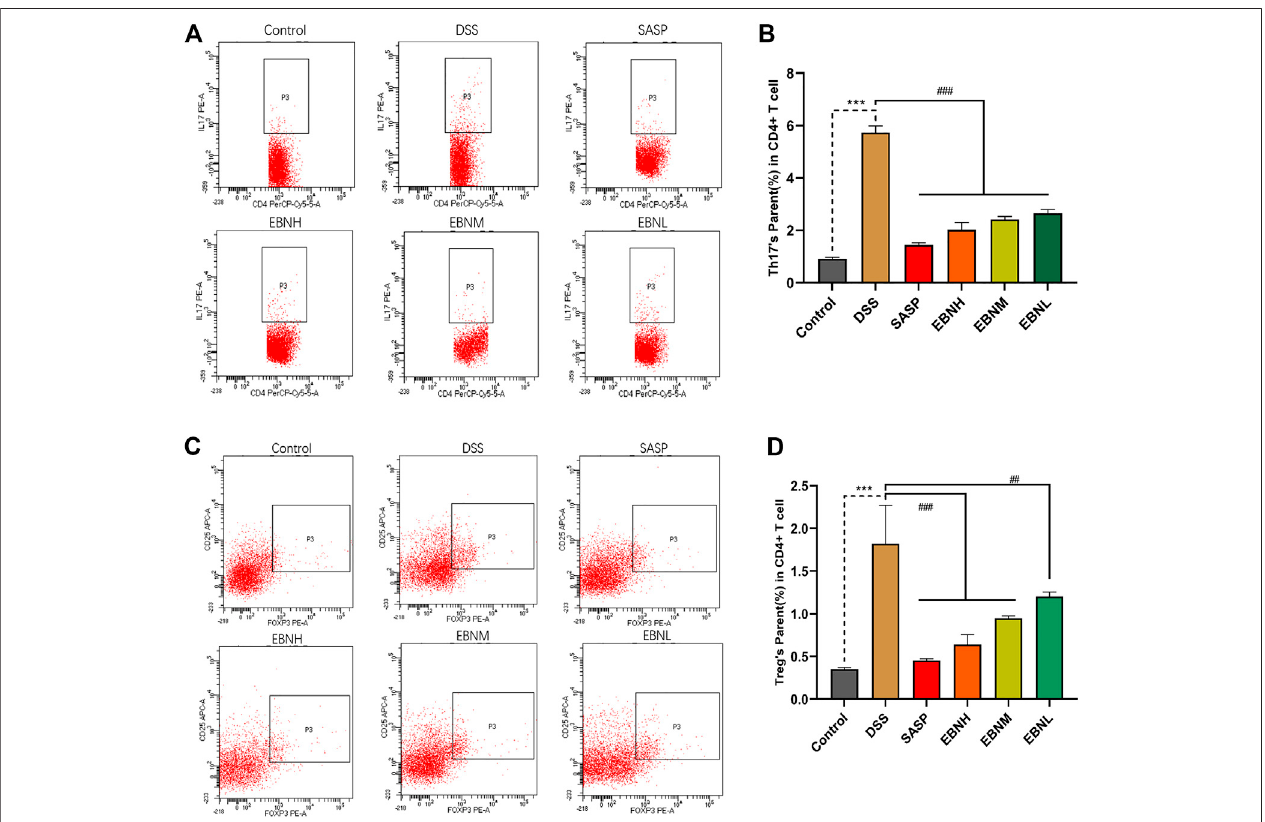
FIGURE 5 | Effects of EBN pretreatment on the proportions of Th17 cells and Treg cells in the CD4 + T cell compartment of the spleen. (A,B) Effect of EBN on the proportionofCD4 + IL-17A + Th17cellsinthespleenofmicewithcolitis. (C,D) EffectofEBNontheproportionofCD25 + Foxp3 + Tregcellsinthespleenofmicewithcolitis. *** P < 0.001 compared with the control group; # P < 0.05, ## P < 0.01 and ### P < 0.001 compared to the DSS group ( x ± S , n (cid:2)